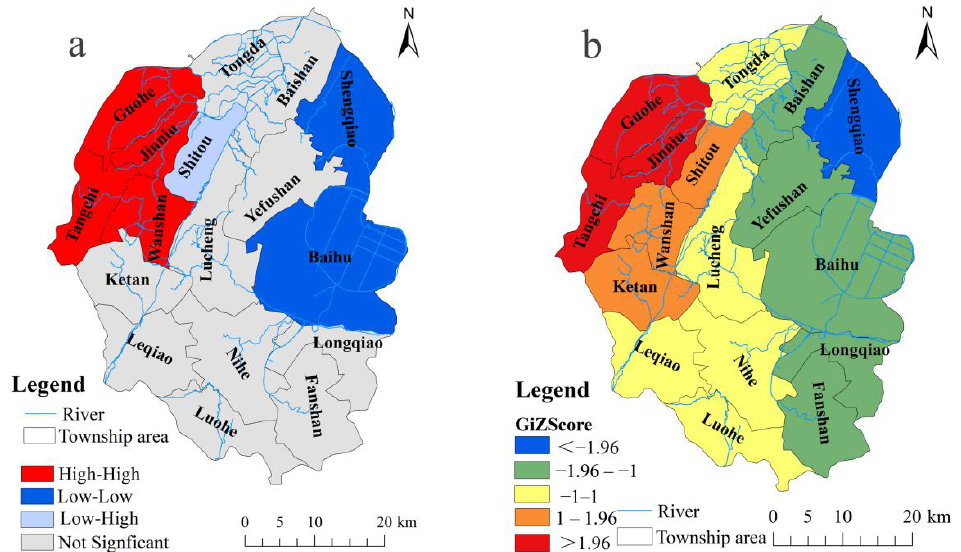
Figure 4. The Local Indications of Spatial Association clusters ( a ) and Local G i * hot spot clusters ( b ) of the incidence of digestive tract cancer in Lujiang County from 2012 to 2017. Cancer incidence is not only reflected on the spatial scale, but also in the time